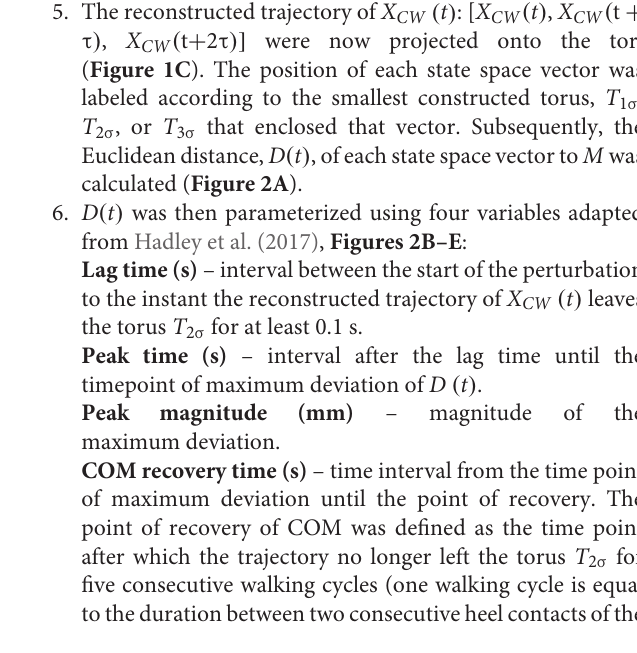
(Wurdeman, 2016; Supplementary Methods 1 ).